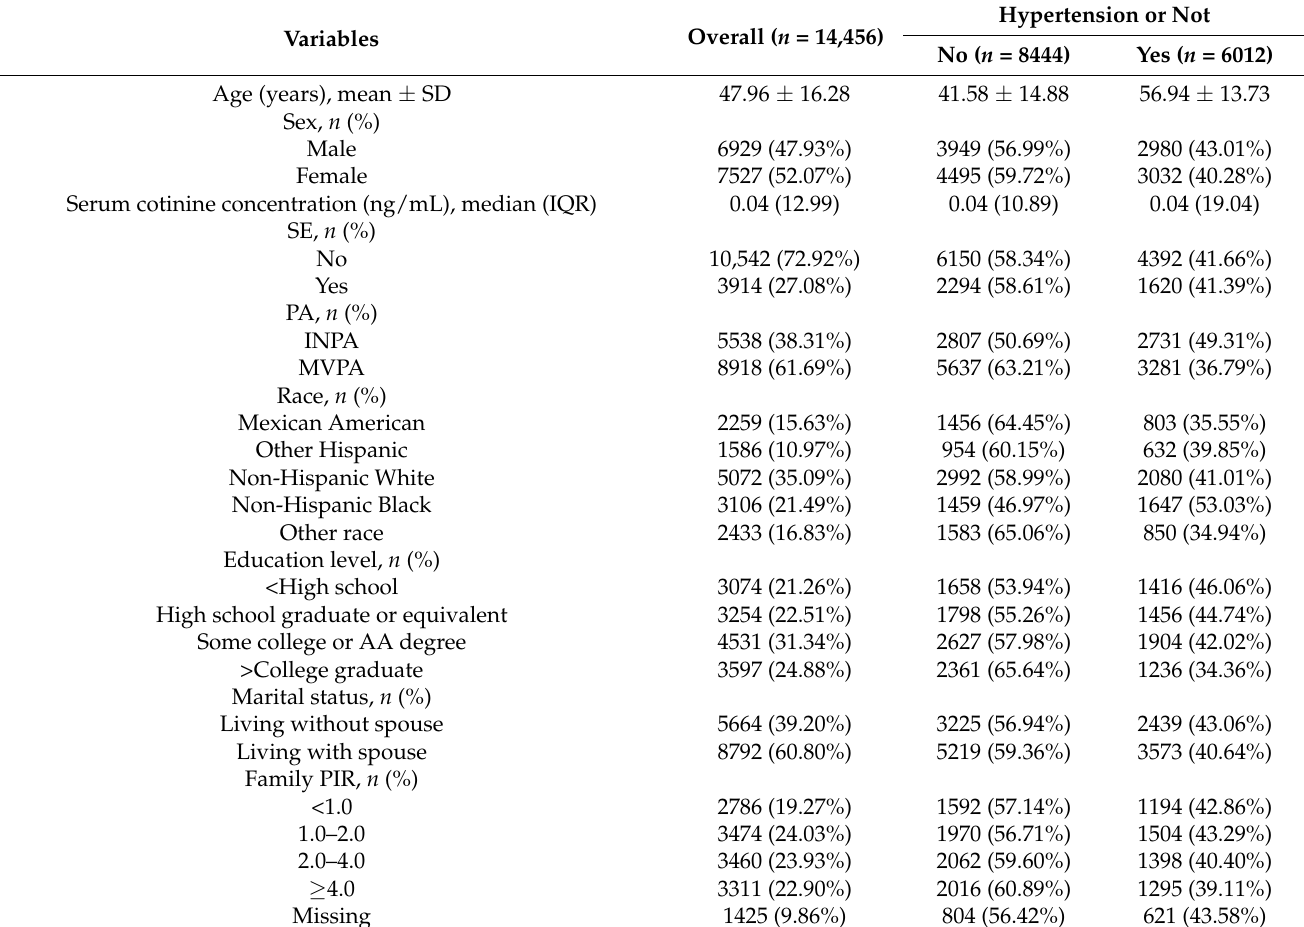
Table 1. General characteristics of